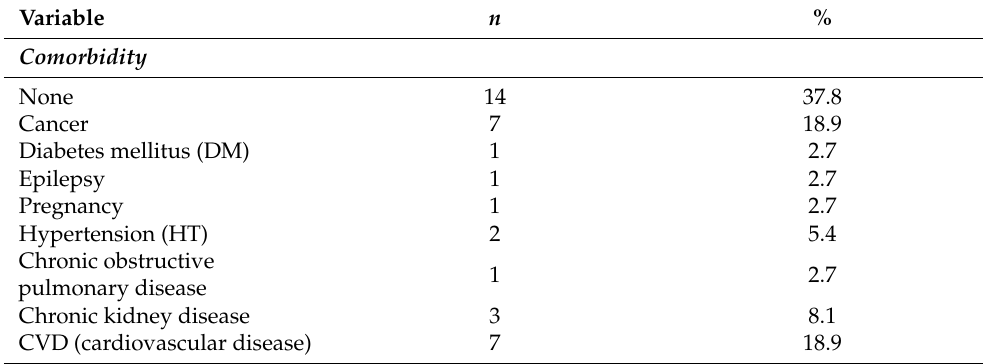
Table 2. Distribution of patients according to the presence of comorbidities ( n =37).